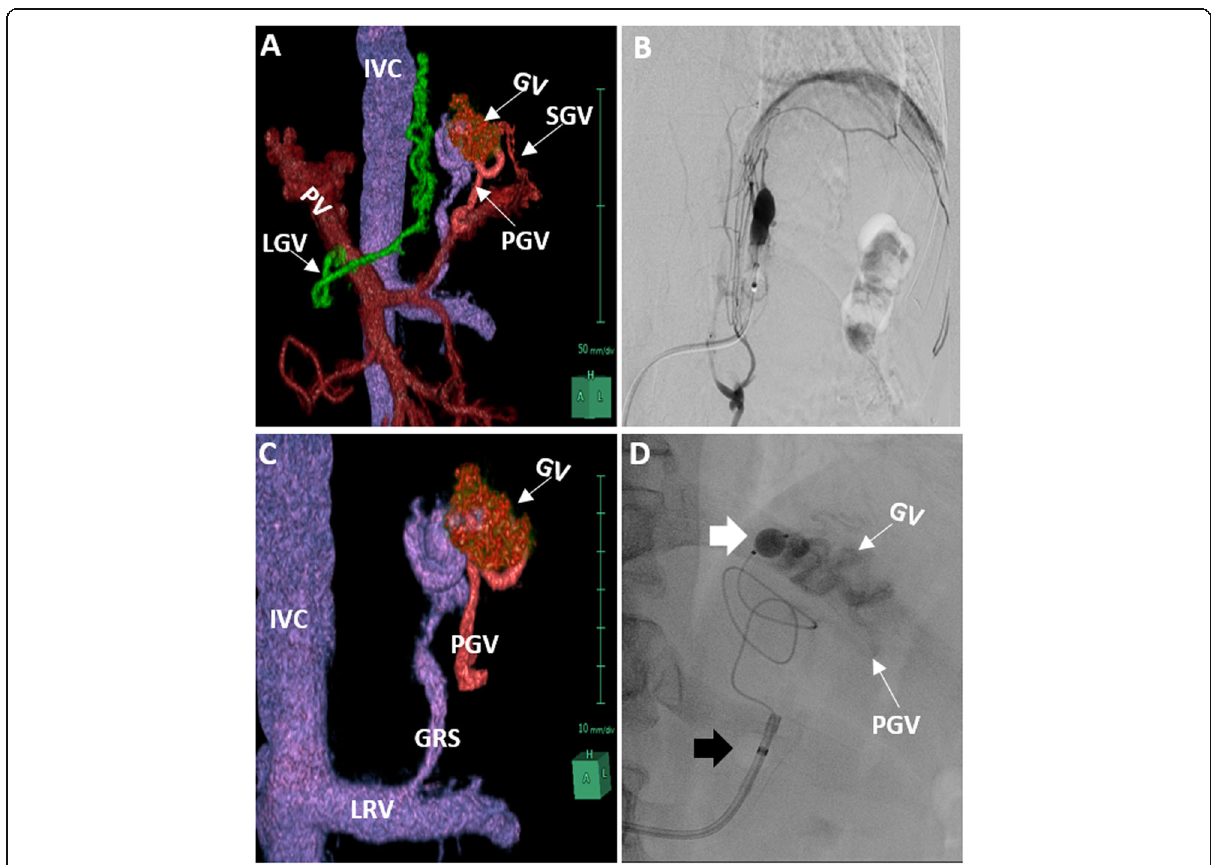
Fig. 4 Superselective BRTO technique. a O blique volume rendering (VR) image obtained from pre-BRTO CE-CT portal phase images shows GV supplied by posterior gastric vein (PGV) and small short gastric vein (SGV) and drained by gastrorenal shunt (GRS). b DSA image during balloon occluded retrograde venography of the GRS shows multiple medium sized collateral veins without contrast opacification of the GV. c The same as VR image in a but magnified showing only GRS, GV and PGV as a reference image for image d . d Fluoroscopic image at the end of BRTO shows 9F balloon guiding catheter positioned at lower GRS (solid black arrow) while microballoon catheter (white solid arrow) was positioned at the junction point between GRS and GV. There is complete opacification of GV and part of PGV with